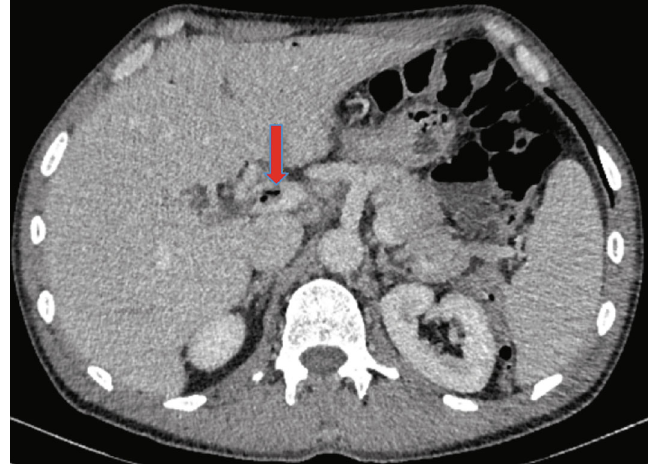
Figure 1: Portal vein thrombosis with intraluminal